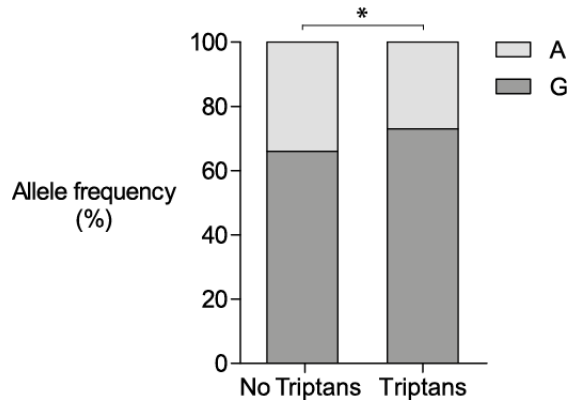
Figure 1. rs2682826 allele frequencies in patients using and not using triptans. Allele frequency of nNOS rs2682826 in triptan users ( n = 388) vs. nontriptan users ( n = 140). Analysis showed an association using Fisher’s exact test, two-tailed p -value, * = p -value < 0.05, OR = 0.72, 95% confidence interval =